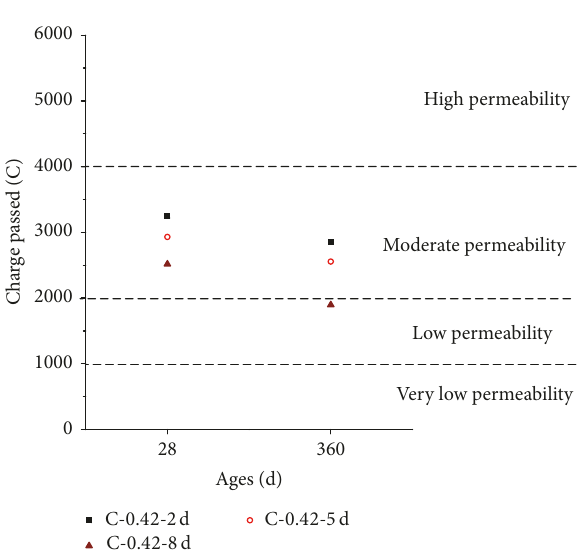
Figure 8: Chloride permeability of fly ash